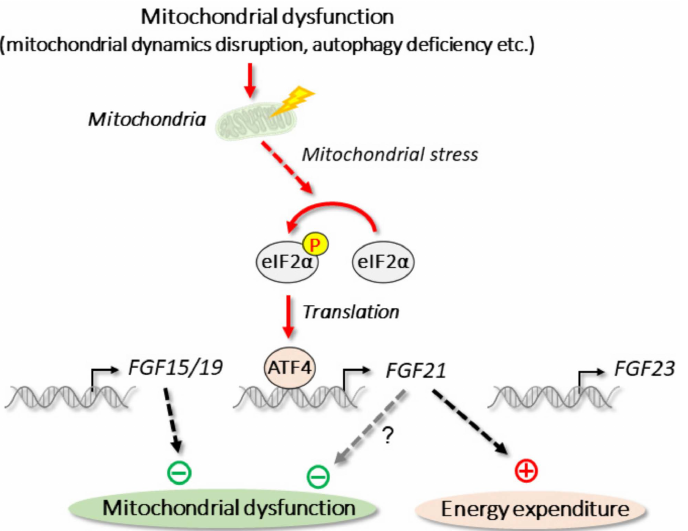
Figure 4. Mitochondrial stress and endocrine FGFs. Mitochondrial stress is triggered by mitochon- drial dysfunctions or by deficiency of mitochondrial dynamics-related gene OPA1 or autophagy- related gene ATG7 . In skeletal muscle, mitochondrial stress induces FGF21 through eIF2 α –ATF4